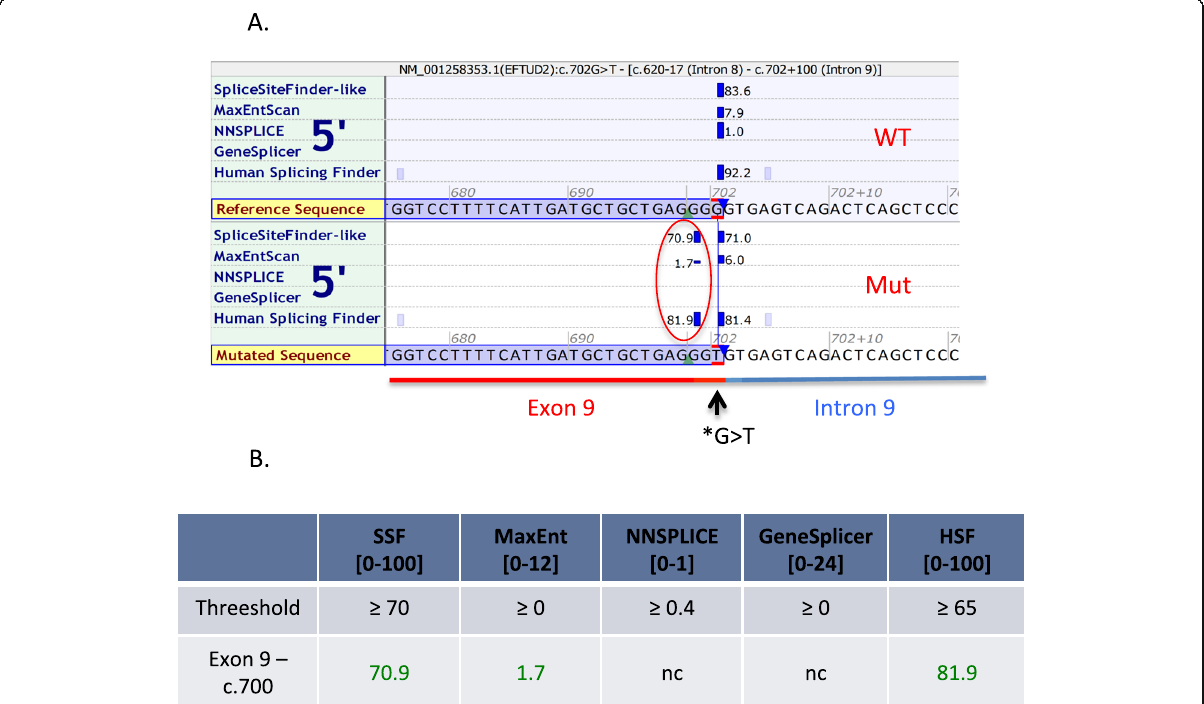
Fig. 2 In silico predictions of the impact of NM_004247.4 ( EFTUD2 ): c.702G > T variant on splicing. a Screenshot of in silico predictions of the impact of EFTUD2 c.702G > T variant using Alamut software. Three out of five tools predicted that the G > T variant creates a new 5 ′ donor splicing site (red circle) in the mutated sequence (bottom rectangle) compared to wildtype sequence (top rectangle). The exon 9 (red) and intron 9 (blue) are highlighted on the Figure. b The table represents the splicing scores for the new 5 ′ donor splicing site by the five predicators tools. The threshold score to reach predicting the presence of a donor splice site is indicated for each predicator